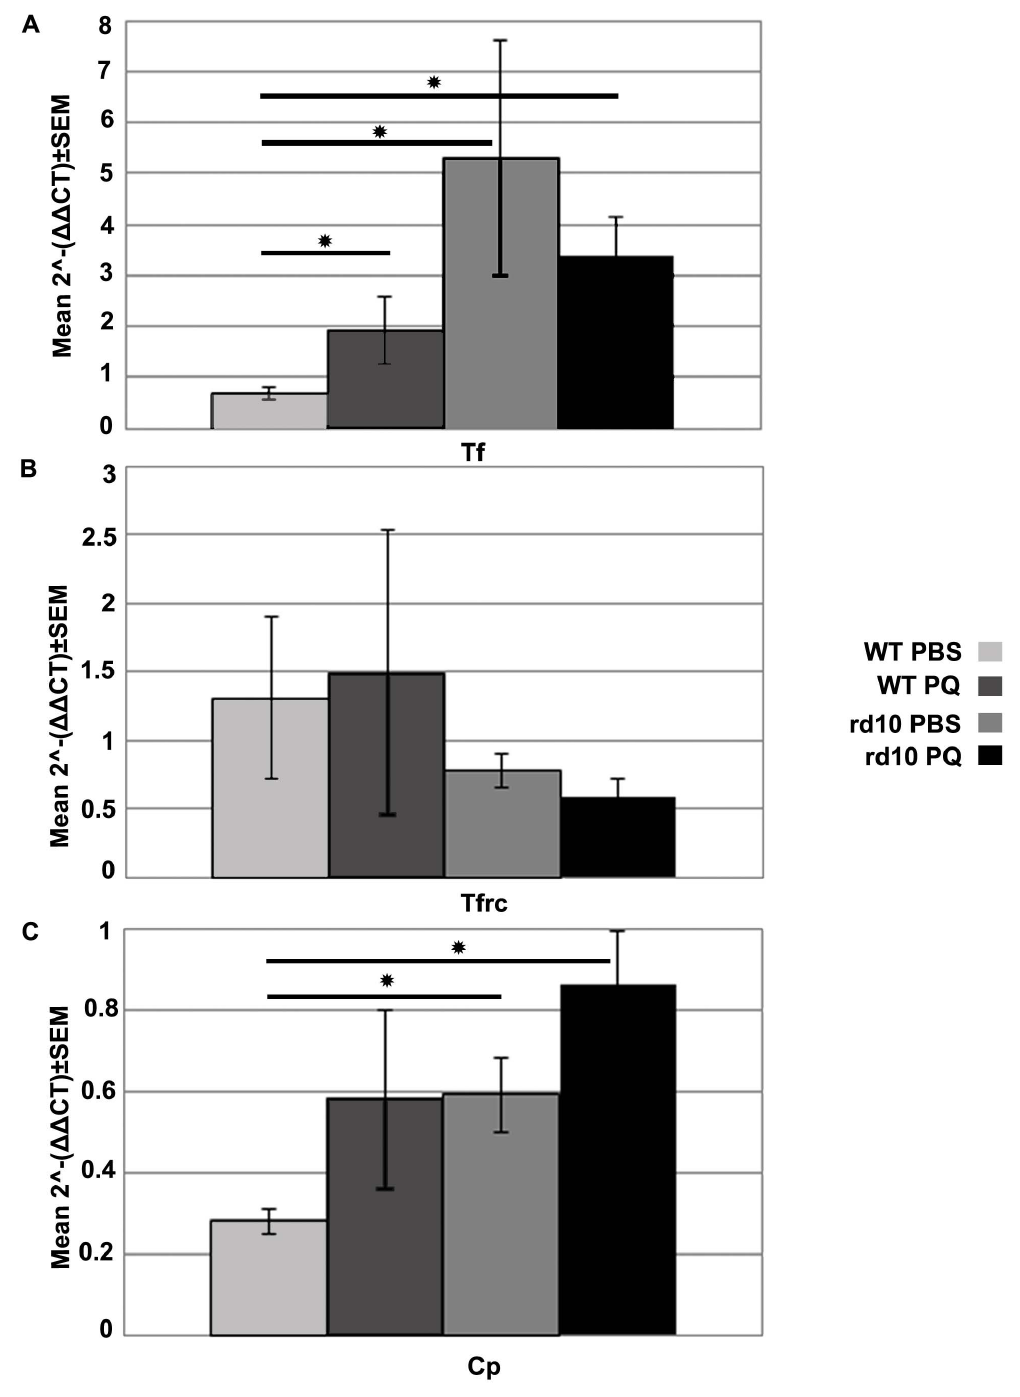
Figure 8. mRNA levels of iron metabolism associated genes. (A) transferrin (Tf) expression, (B) transferrin receptor ( Tfrc) expression, (C) ceruloplasmin (Cp) expression, measured in rd10 and WT retinas following intravitreal injection of 1 m l of 2 mM PQ or PBS. Bars=mean relative mRNA levels 6 SEM. *p , 0.05 as compared to PBS injected eyes (PBS) of same strain. { p , 0.05 comparing expression in control eyes between the strains (n=6 pairs in each group). doi:10.1371/journal.pone.0087751.g008 which supernatant was separated and refrozen at 2 80 u C. Protein content was estimated using the BCA Protein Assay Kit (Pierce, Rockford, IL). Ferritin levels were measured by ELISA as was previously described [17,26].